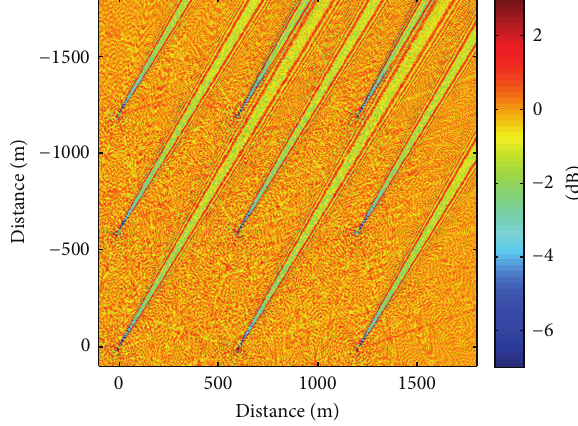
Figure 9: Near-field distribution around a 3 × 3 wind farm at 150MHz.